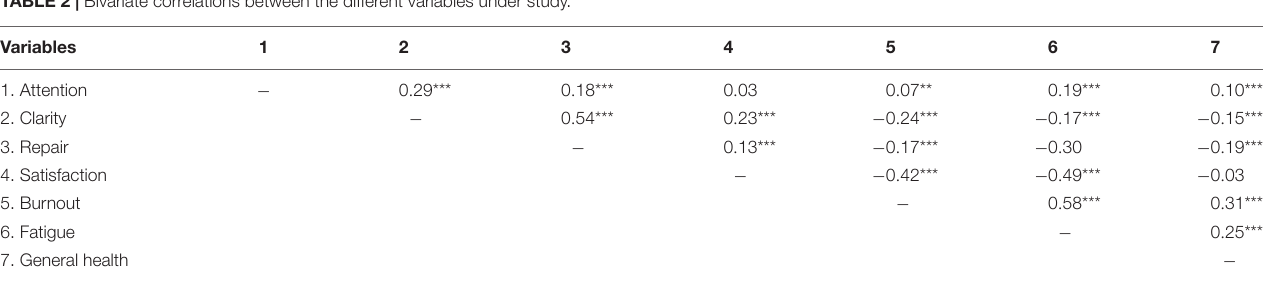
TABLE 2 | Bivariate correlations between the different variables under study.